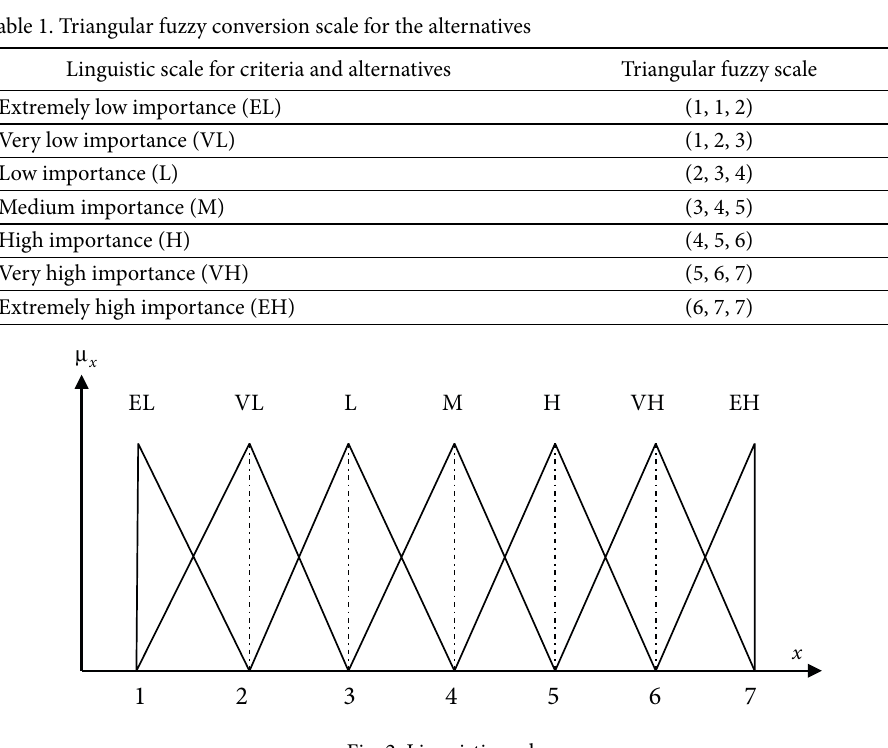
Fig. 2. Linguistic